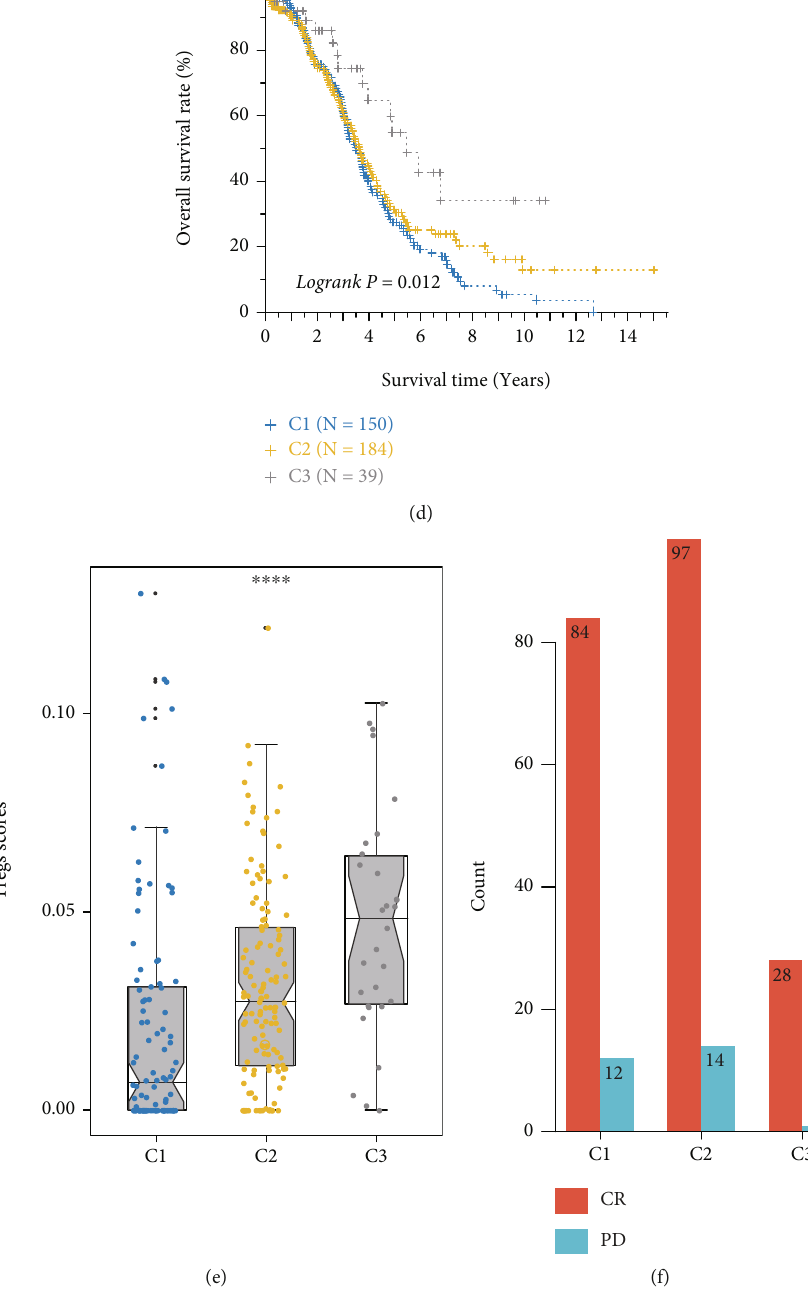
Figure 2: Prognostic analysis of di ff erentially expressed immune genes. (a) Hazard ratios of the 14 prognostic DEGs. The rectangle size represented the -log10 of p value. CI: con fi dence interval. (b) The expression values of 13 prognostic DEGs validated in the GSE173201 dataset. (c) The expression pro fi les of 14 prognostic DEGs in TCGA-OV dataset. The up dendrogram showed the hierarchical clustering results of TCGA-OV samples. The up side bars indicated the three groups C1, C2, and C3. (d) Survival curves showed the overall survival rate of the samples between three groups. (e) The Treg scores of the samples between three groups. (f) The distributions of CR and PD samples between the three groups. CR: chemotherapy response; PD: disease